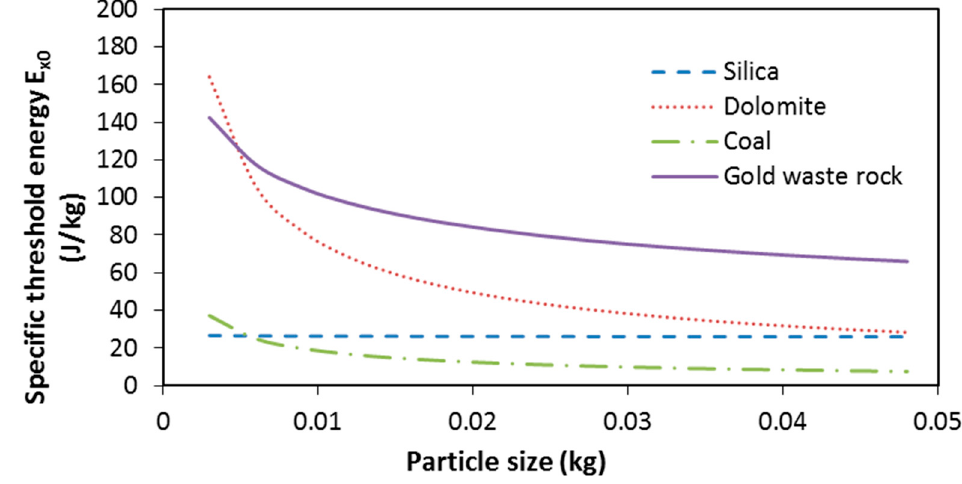
Figure 11. Comparison of specific threshold energy (J/kg).